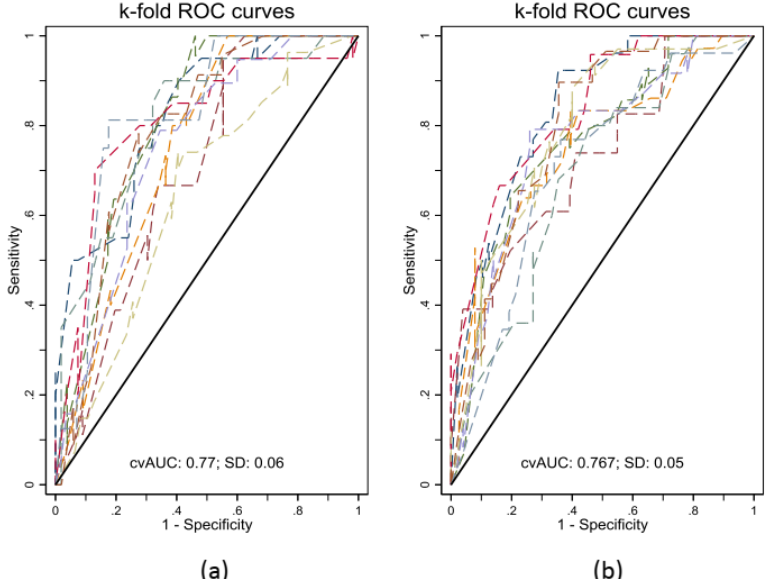
Figure 3. Internal validation of the models using 10-fold cross validation for masked uncontrolled hypertension defined by daytime blood pressure (BP) threshold ( a ), regardless of nighttime BP, and by 24 h BP threshold ( b ), regardless of daytime or nighttime BP. Abbreviations: AUC, area under the curve; SD, standard deviation.